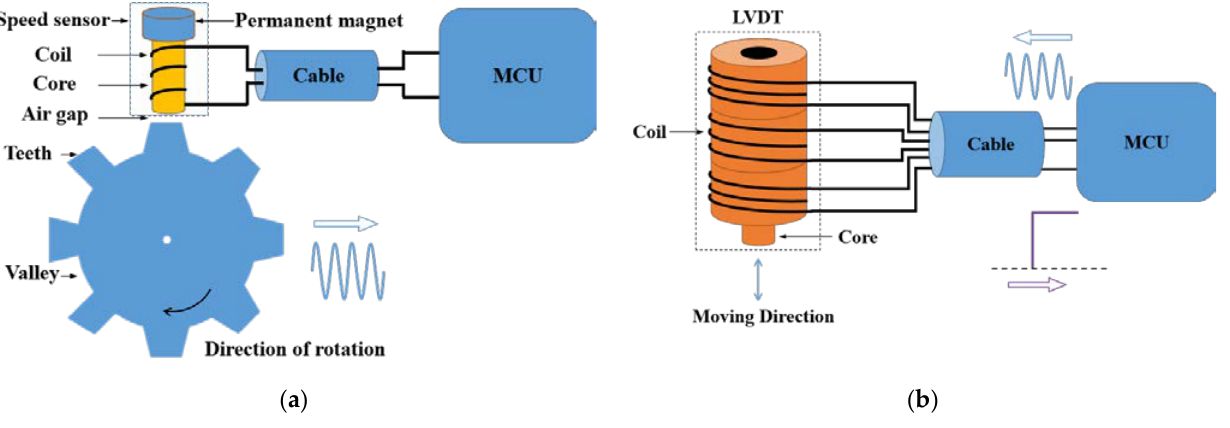
Figure 16. Working process of sensors: ( a ) Speed sensor; ( b ) LVDT sensor.